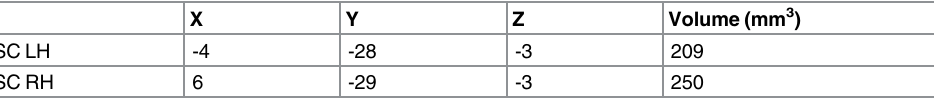
Table 4. Mean and standard error of normalised signal change for each saccade event type in the